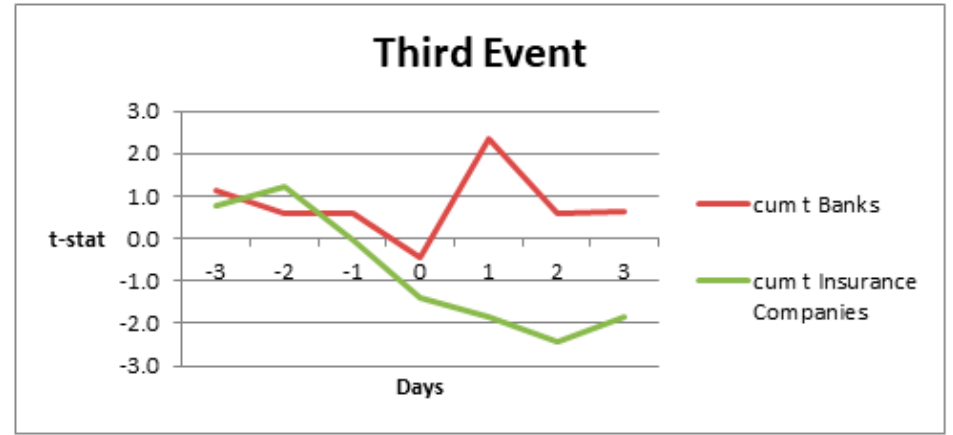
Figure 15. Cumulative t for banks and cumulative t for insurance companies. Source: Authors’ work.